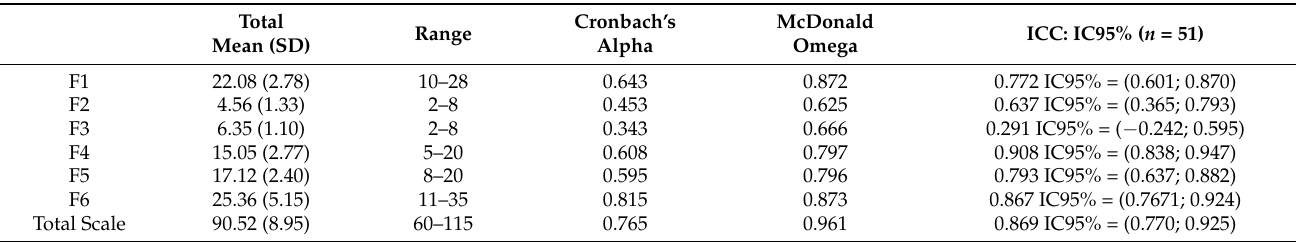
Table 5. Scores of the scale and the dimensions: description, reliability, internal consistency, and test-retest